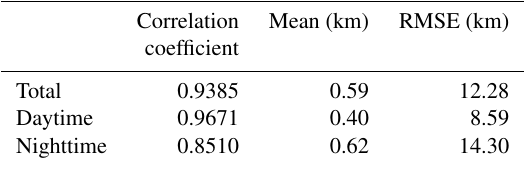
Table 2. Absolute error of hm F2 between CSES and